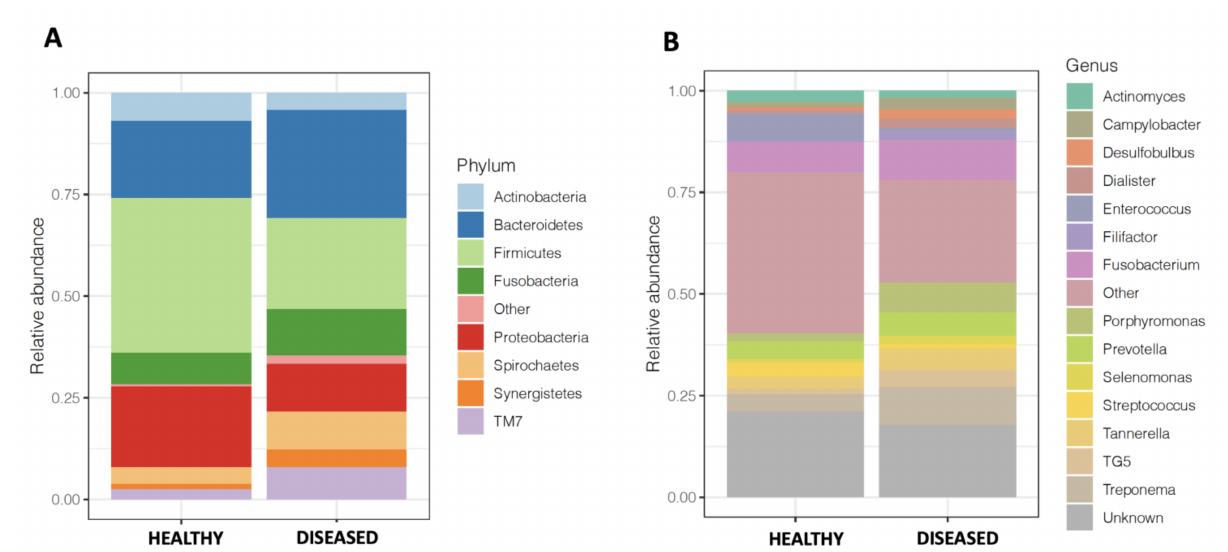
Figure 2. Taxonomic profile of the oral microbiomes of the samples collected in periodontitis sites and healthy sites. ( A ) Mean relative taxa abundance plots for individuals from the samples collected in periodontitis sites and healthy sites, summarized at the phylum level. ( B ) Mean relative taxa abundance plots for individuals from the samples collected in periodontitis sites and healthy sites, summarized at the genus